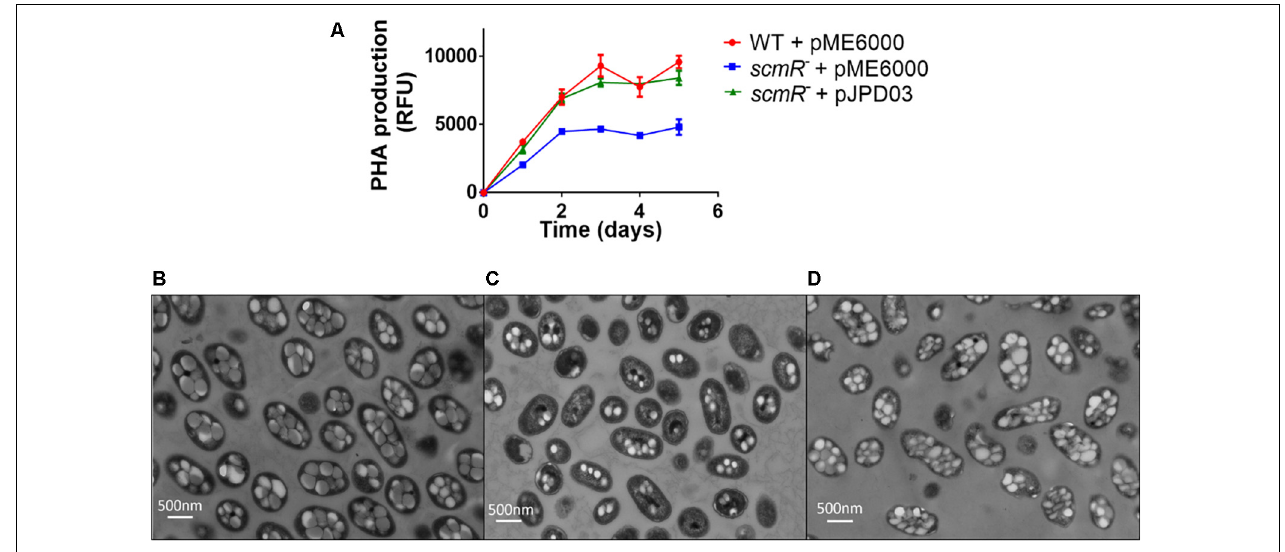
FIGURE 4 | ScmR positively affects PHA biosynthesis. (A) PHA levels were determined by fluorescence following Nile Blue staining. The values are means ± standard deviation (error bars) for three replicates. (B–D) represent TEM images of E264, the scmR- mutant and the complemented scmR - mutant, respectively at a magnification of